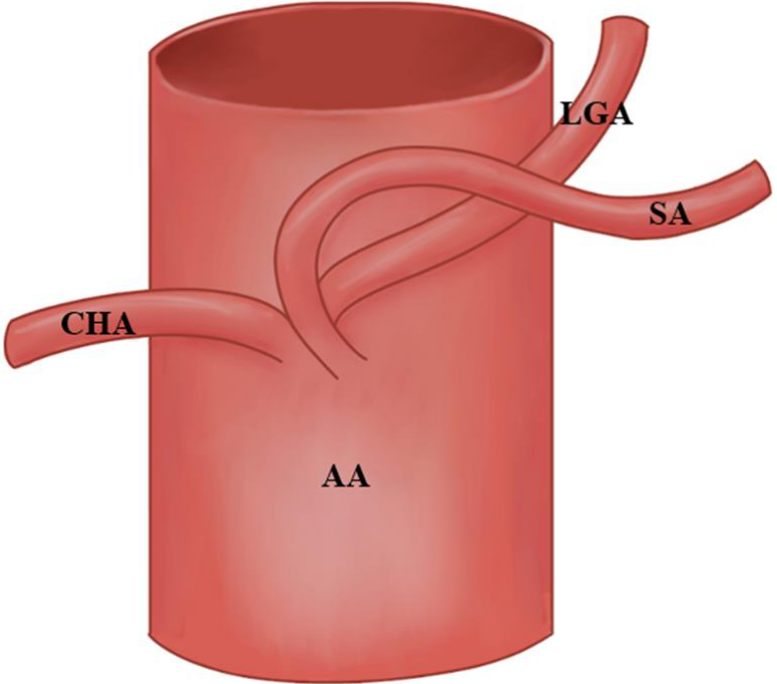
Figure 3. The image shows the splenic artery arising from the abdominal aorta. Abbreviations: abdominal aortic (AA), splenic artery (SA), common hepatic artery (CHA), left gastric artery (LGA). The hepato-spleno-mesenteric trunk is an anatomical variation in which the hepato- splenic trunk and the superior mesenteric artery arise from a common vessel, while the left gastric artery originates directly from the abdominal aorta slightly superior to the hepato-spleno-mesenteric trunk. Its prevalence is estimated at 0.40% [55]. In this review, seven studies were found that reported the presence of the hepato-spleno-mesenteric trunk [4,33,51,56,57]. These studies are case studies, reporting a similar origin to that de- scribed in the study by Liu et al. (2009). That study had a N of 6 patients; the authors found an SA arising directly from the superior mesenteric artery (SMA) and the common hepatic artery arose from the abdominal aorta [43]. Moreover, the study by Redmond et al. (1989) found that in 126 patients (99.2%) out of 127, the SA arose as a single trunk from the coeliac axis in all but one case, where a second splenic artery was found arising directly from the aorta and supplying the upper pole [44]. Additionally, Bacallao et al. (2017) reported on 15 anatomical preparations: 5 in adult humans, 3 of the male sex and 2 of the female sex, with ages ranging between 48 and 63 years, and 10 human fetuses, between 20 and 29 weeks of age, 6 female and 4 male. They found that three adult human spleens had an SA origin at the celiac trunk and the remaining 40% of adult spleens had a direct tripod origin from the anterior aspect of the abdominal aorta. Regarding the sample of fetuses, it was found that in fetuses between 20 and 24 weeks, the AS originated in the celiac trunk in three (75%), while the remaining fetus showed an AS originating in the form of a direct tripod from the anterior wall of the abdominal aorta (25%). In fetuses from 25 to 29 weeks, five (83.3%) had an SA originating from the celiac trunk and one (16.7%) from the tripod shape, in which the SA was the longest [16]. The celiac – mesenteric trunk is an extremely rare anatomical variant in which the ce- liac trunk and the superior mesenteric artery originate from the abdominal aorta through a common trunk. According to the study carried out by Poynter, the celiac – mesenteric trunk represents less than 1.4% of all anomalies in the origin of the splenic artery [58]. Ekingen et al. (2019) found eight (1.07%) (two females, six males) instances of SA originat- ing from the celiacomesenteric trunk (CMT), which they described as type 5 CMTs [34].